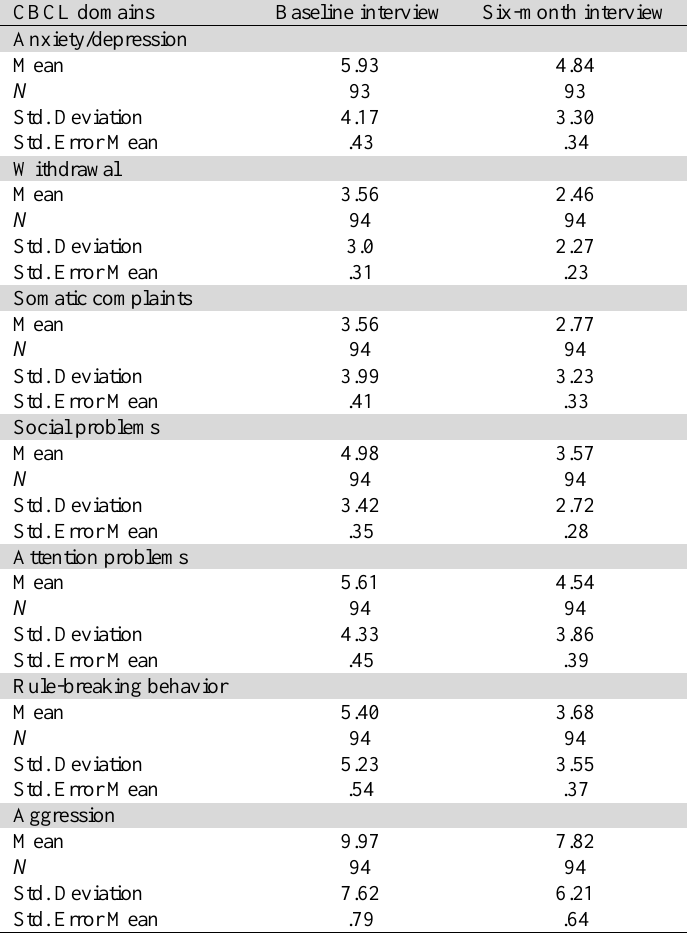
Table 1 Descriptive statistics of child behaviour as assessed by the mother participants on the CBCL CBCL domains